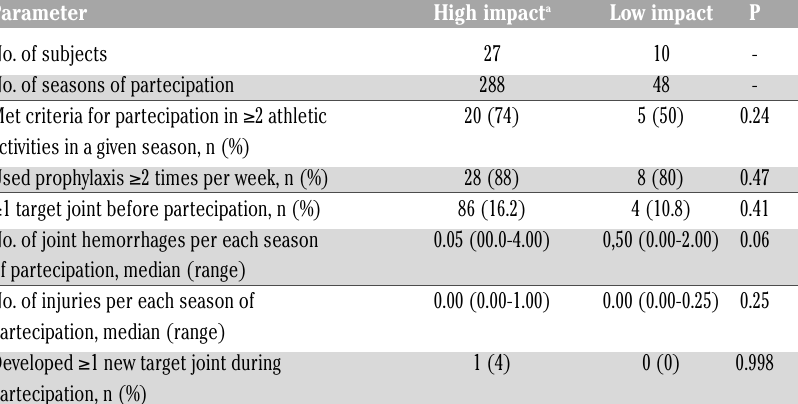
Tabella 2. Risultati dello studio (16) sulle differenze tra bambini emofilici in profilassi che prativcano attività sportive ad alto o basso rischio di danno